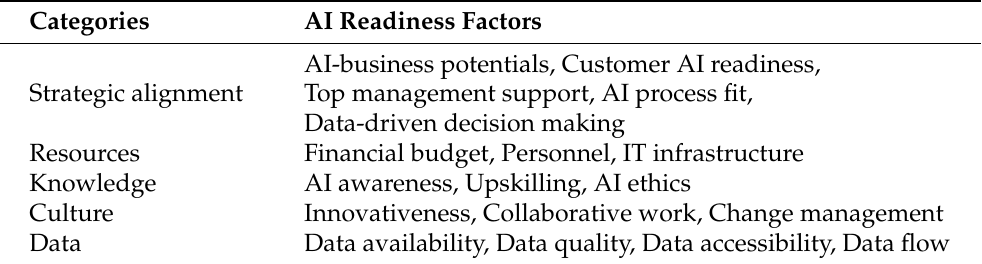
Table 4. Organizational AI Readiness